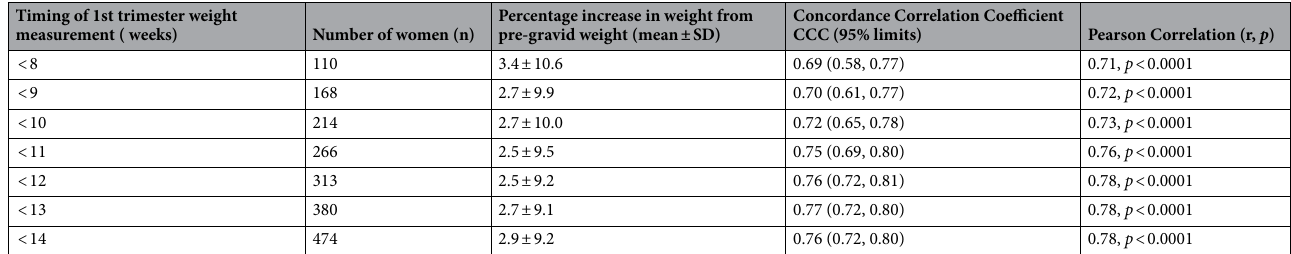
Table 2. Association between pre-gravid weight and first trimester weight in relation to the timing of the latter measurement within the first 14 weeks of gestation.